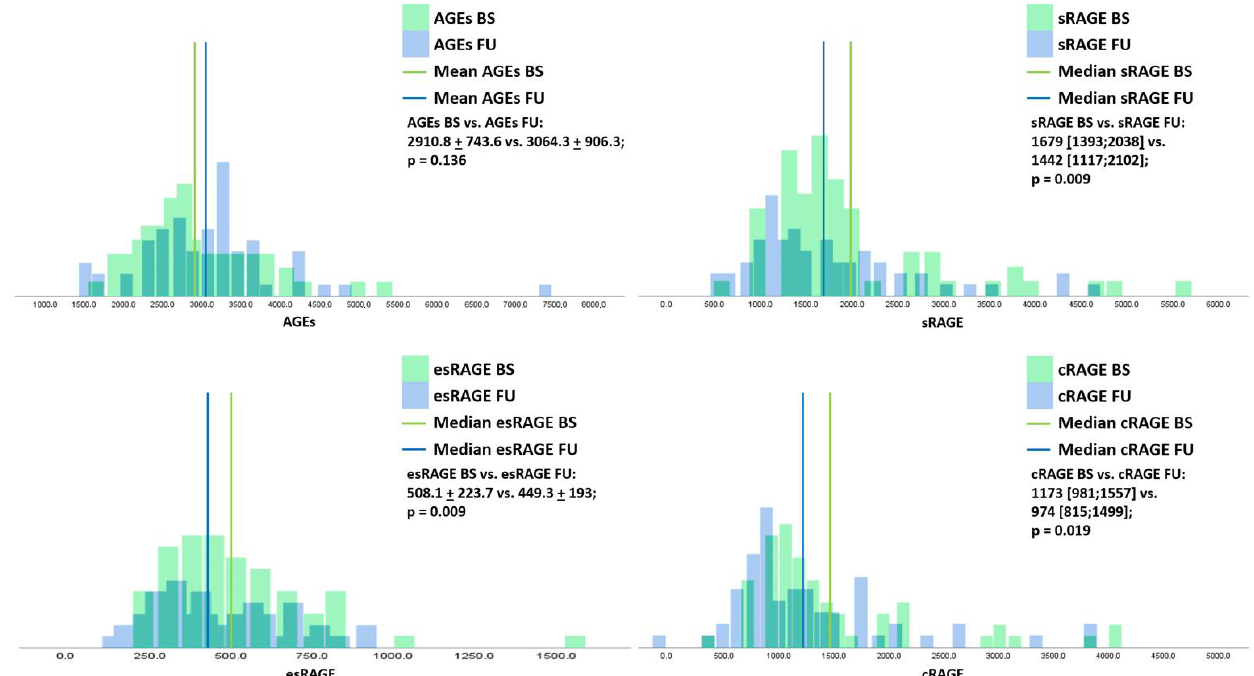
Figure 2. Distribution of advanced glycation end products (AGEs), and soluble receptor for AGE (sRAGE) and its isoforms’ distribution at baseline and follow-up. BS: baseline; FU: follow-up; AGEs: advanced glycation end products; sRAGE: soluble receptor for advanced glycation end products receptor; esRAGE: endogenous secretory receptor for AGE; cRAGE: clivated receptor for AGE.